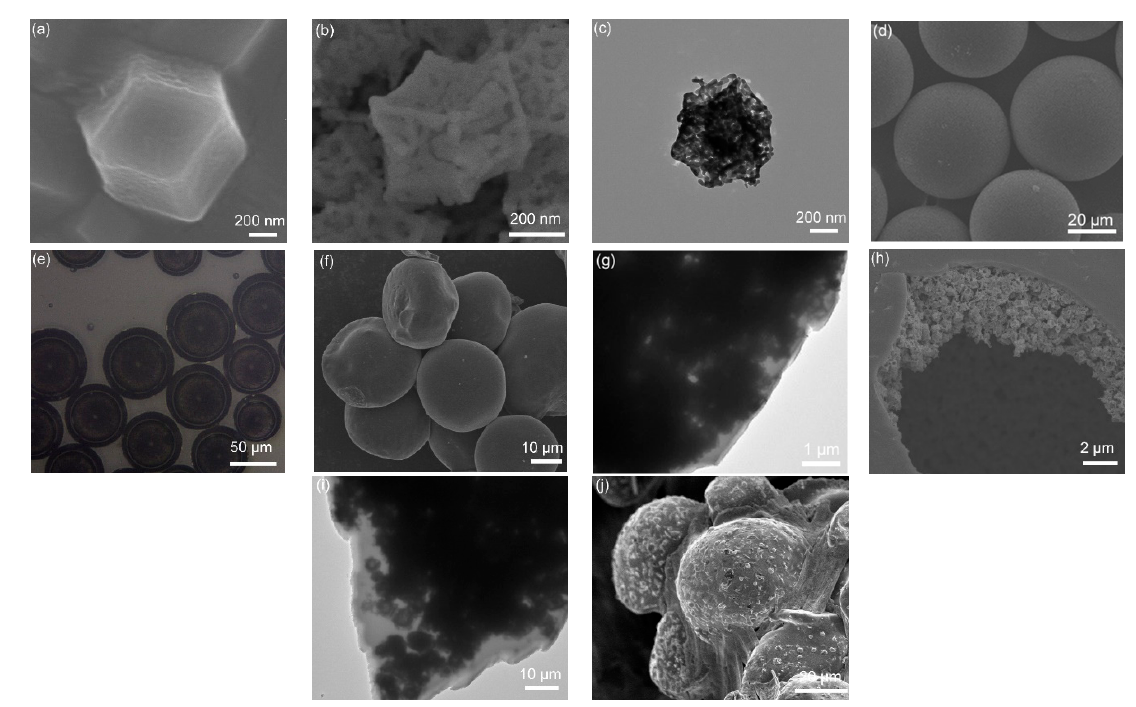
Figure 2. SEM photographs of ( a ) ZIF-67 and ( b ) dodecahedral Co 3 O 4 nanocage. ( c ) TEM image of Co 3 O 4 . ( d ) SEM and ( e ) optical photographs of Co 3 O 4 -infilled microcapsules before carbonization. ( f ) SEM and ( g ) TEM images of carbonized microcapsules. ( h ) SEM and ( i ) TEM photographs of Co 3 O 4 -infilled microcapsule after breaking manually. ( j ) SEM image of microcapsules after loading sulfur.